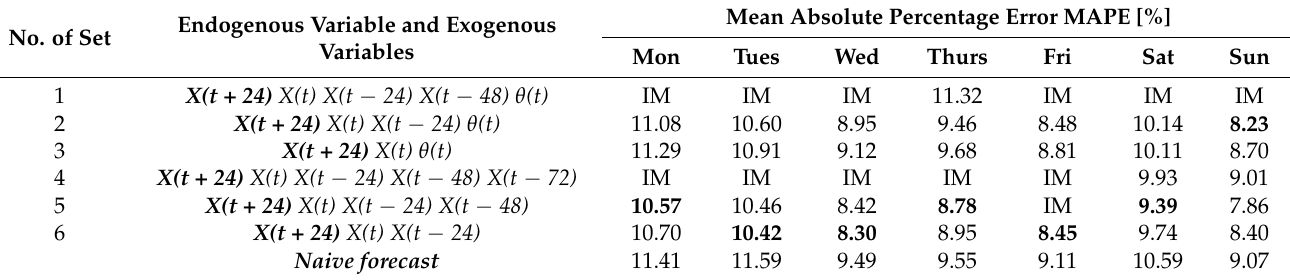
Table 2. MAPEs for ex post forecasts of loads.